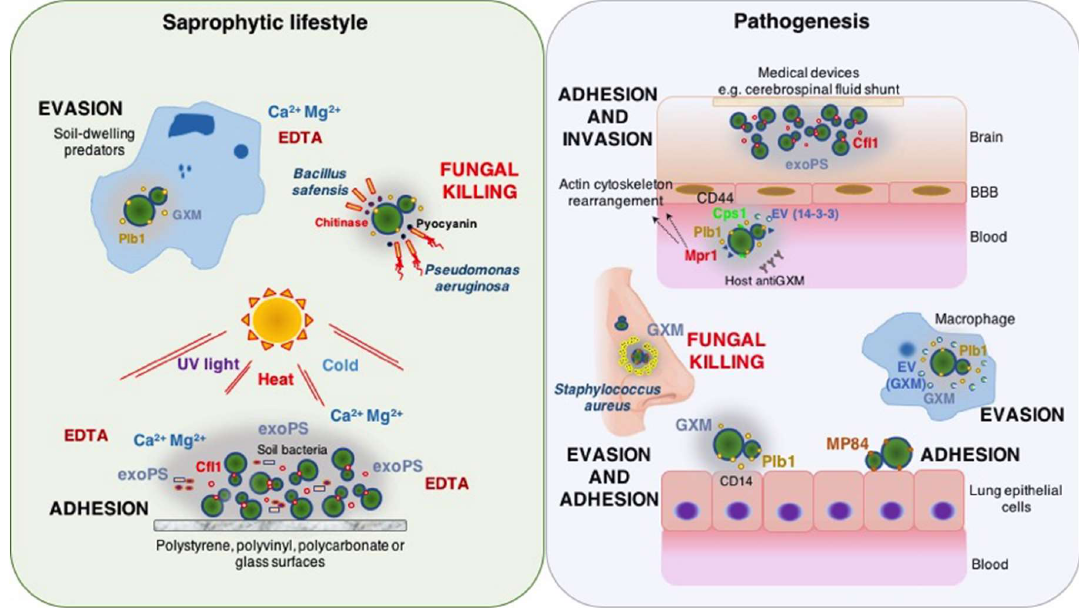
Figure 1. Cryptococcus spp. display multiple “cards” of virulence. Unique cryptococcal attributes allow these fungi survival in harsh soil (saprophytic lifestyle) and animal (pathogenesis) environments, as well as binding to abiotic and biotic surfaces promoting nutrient acquisition or tissue colonization and invasion. However, under certain conditions these microbial traits could promote the interaction with other microorganisms that negatively impact fungal viability. In nature, the cryptococcal capsular polysaccharide is a critical component mediating fungal survival amongst soil-dwelling predators. It also allows this microorganism to establish symbiotic communities with other microbes through biofilm formation in response to environmental stressors. In an intracellular setting, cryptococcal yeasts exploit an array of attributes tailored to specific micro-environments. The ultimate aim is overcome the immune defenses and successfully invade host tissues (lung epithelial cells or brain). GXM: glucuronoxylomannan. exoPS, exopolysaccharides (mainly GXM). Plb1: phospholipase 1. MP84: mannoprotein 84. Cfl1: cell flocculin 1. Cps1: hyaluronic acid synthase. Mpr1: metalloprotease. EV: extracellular vesicles. BBB: blood brain barrier.